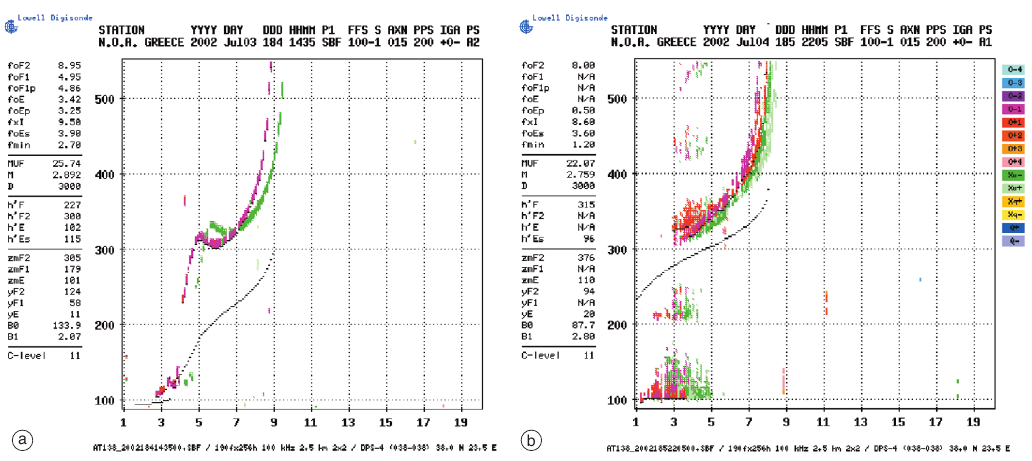
Fig. 1a,b. Ionograms from Athens Digisonde station (a) for the case of undisturbed ionosphere and (b) for a case of spread F